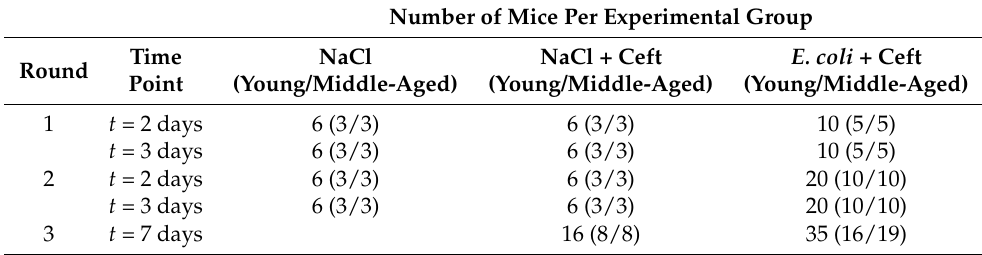
Table A1. Group size per experiment and time point. Ceft =